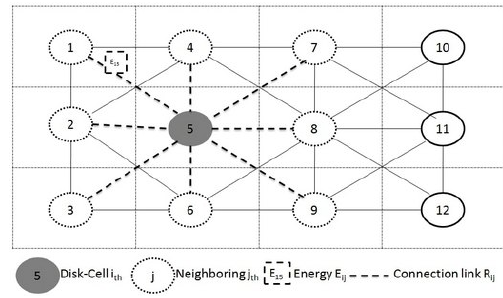
Figure 3: Environment modeling of the modified-GA.